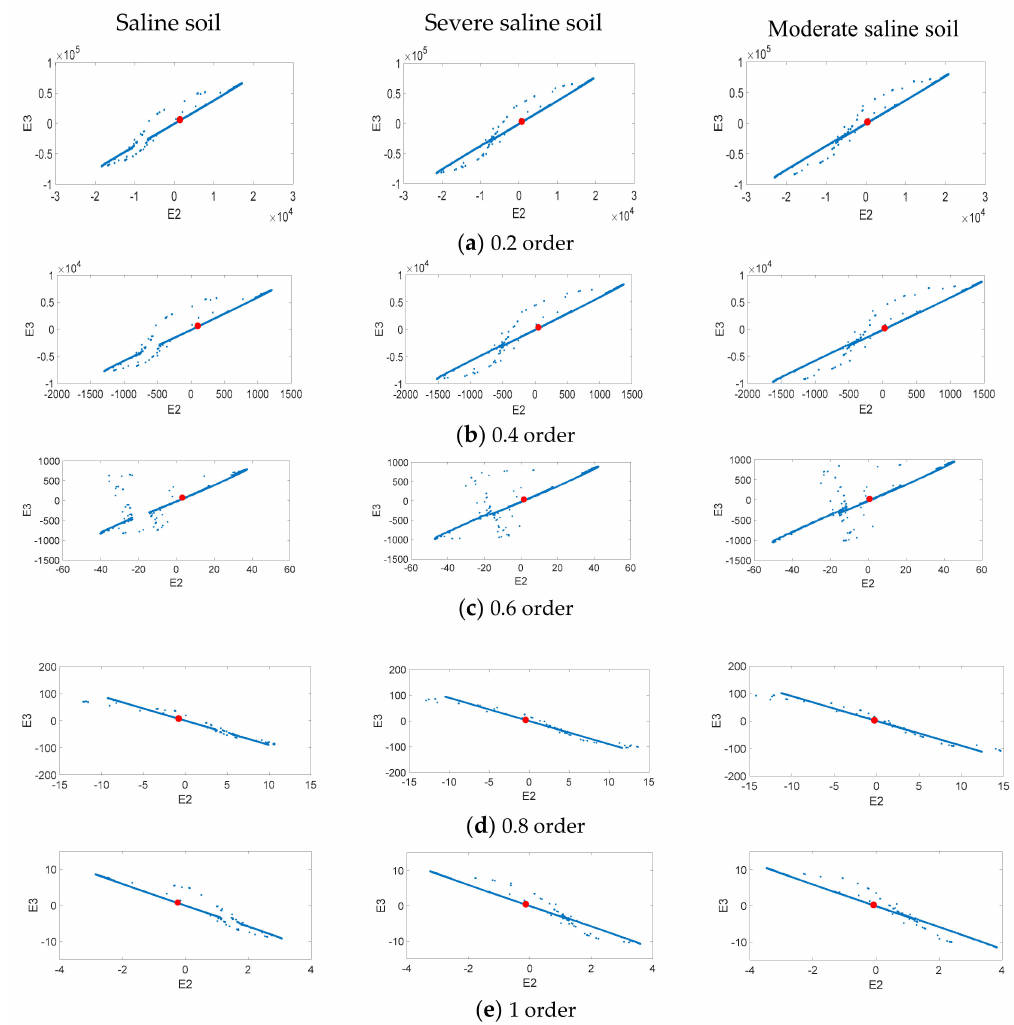
Figure 8. Area A’s chaotic dynamic error